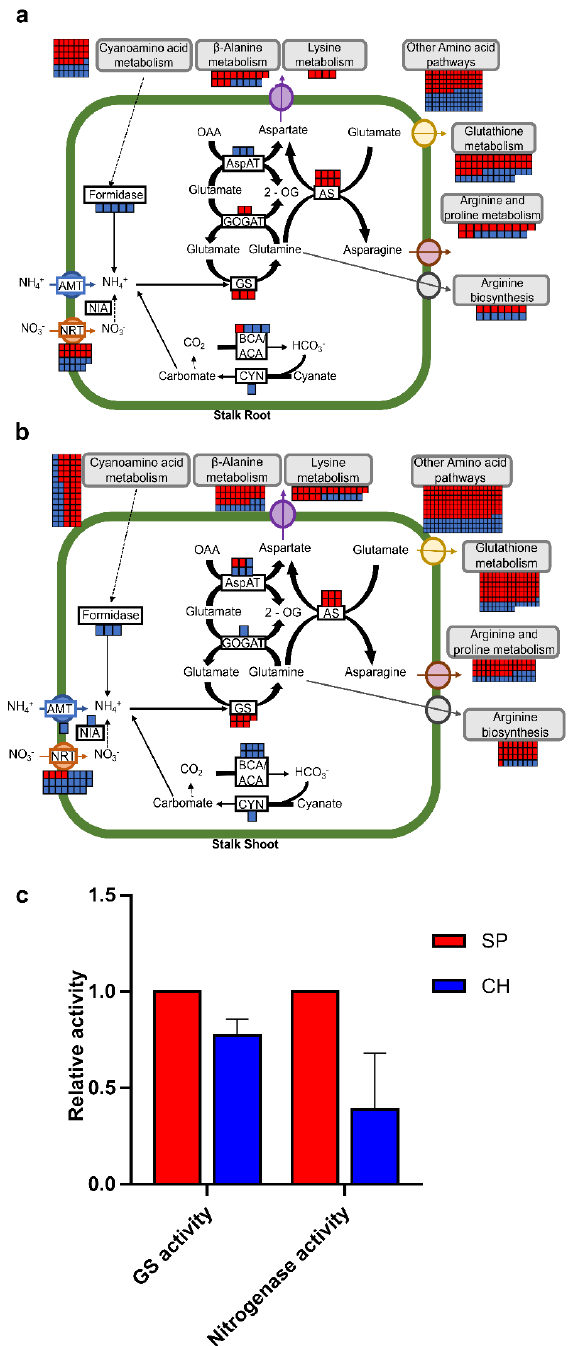
Figure 6. Evaluation of nitrogen and amino acid metabolism pathways differentially regulated between BNF-contrasting genotypes. Schematic representation of N assimilation and transport, showing the DETs identified in root ( a ) and shoot ( b ) tissues of germinated stalks. In red are represented the transcripts that are more expressed in SP and in blue are represented the ones more expressed in CH. ( c ) Enzyme activity of GS and nitrogenase was evaluated in 15-day germinated stalks and is represented as relative activity in relation to SP70-1143 values. Bars represent mean ± standard deviation of five biological replicates. Asterisks (*) represent significant differences be- tween SP and CH through t-test ( p < 0.05). GOGAT—glutamate synthase; GS—glutamine synthe-